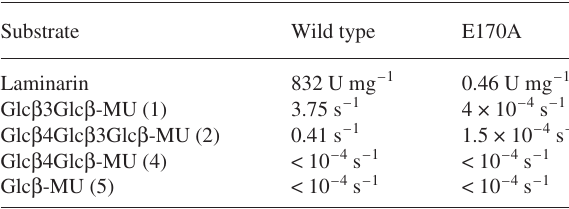
Table 1. Hydrolase activity of wild-type and E170A LamA on laminarin and 4-methylumbelliferyl β -glycosides. Reactions took place at 80 °C in 100 mM phosphate buffer, pH 6.5, containing 0.5% laminarinor 4 mM MU-glycoside. Activity was determinedas release of the chromophoric aglycon (MU =